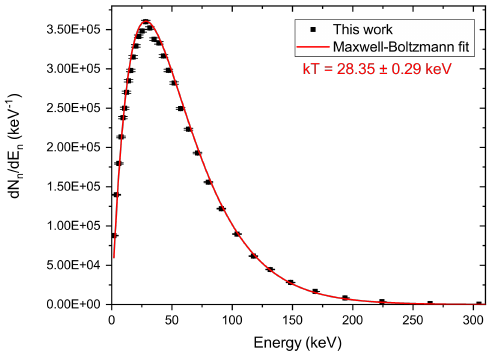
Figure 4. Final angle-integrated, from 0 ◦ to 90 ◦ , neutron energy spectrum and the least squares fit to a Maxwell-Boltzmann